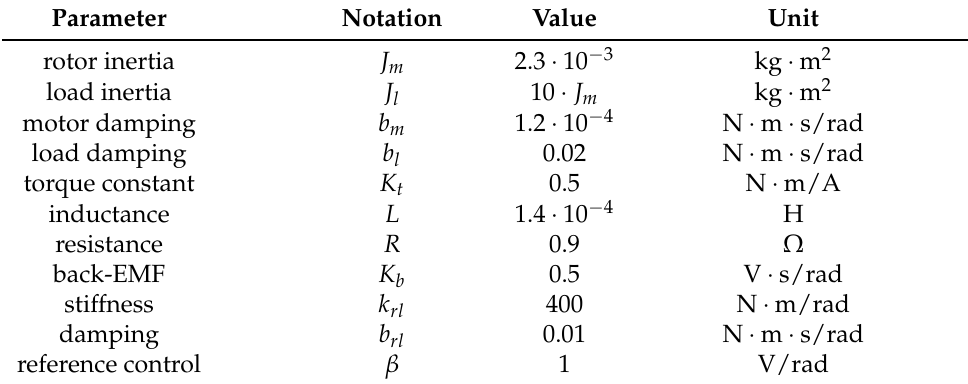
Figure 1. Physical model of the Direct Current (DC) permanent magnet motor driving a softly attached mechanical load. Table 1. Parameters of the investigated motor